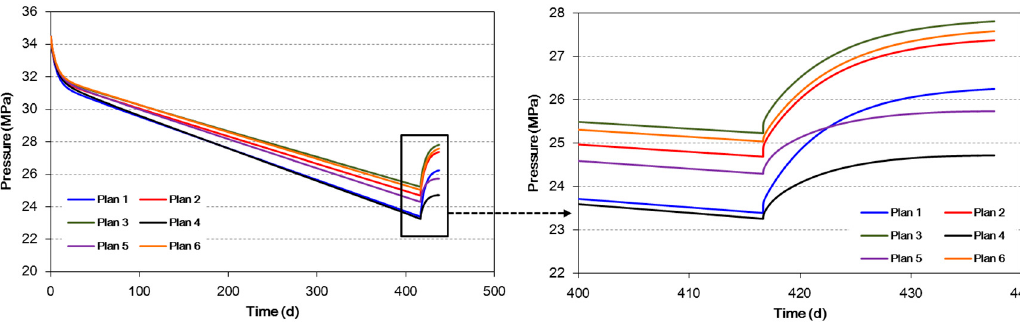
Figure 10. BHP of L2 well after producing 15 months under different well spacing.